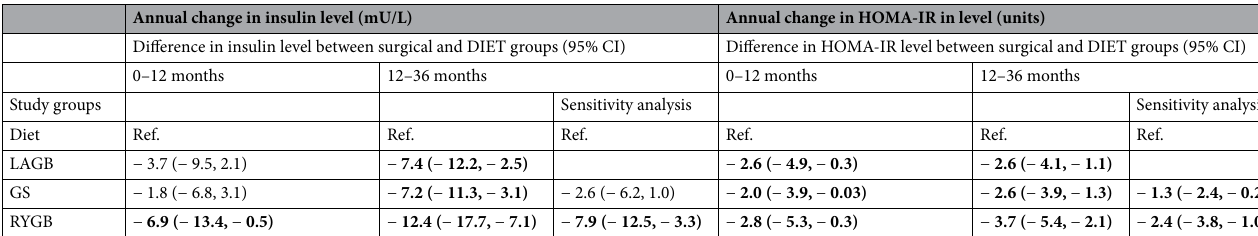
Table 2. Random intercept linear mixed effect models examining comparisons between groups in fasting insulin and HOMA-IR over time. Data presented as annual change in Insulin level (mU/L/year) and HOMA-IR levels (units) with the corresponding 95% CI for two periods: baseline and 12 months, and between 12- and 36- months post intervention. RYGB Roux-en-Y gastric bypass, GS gastric sleeve, LAGB laparoscopic adjustable gastric banding. Boldface indicates statistical